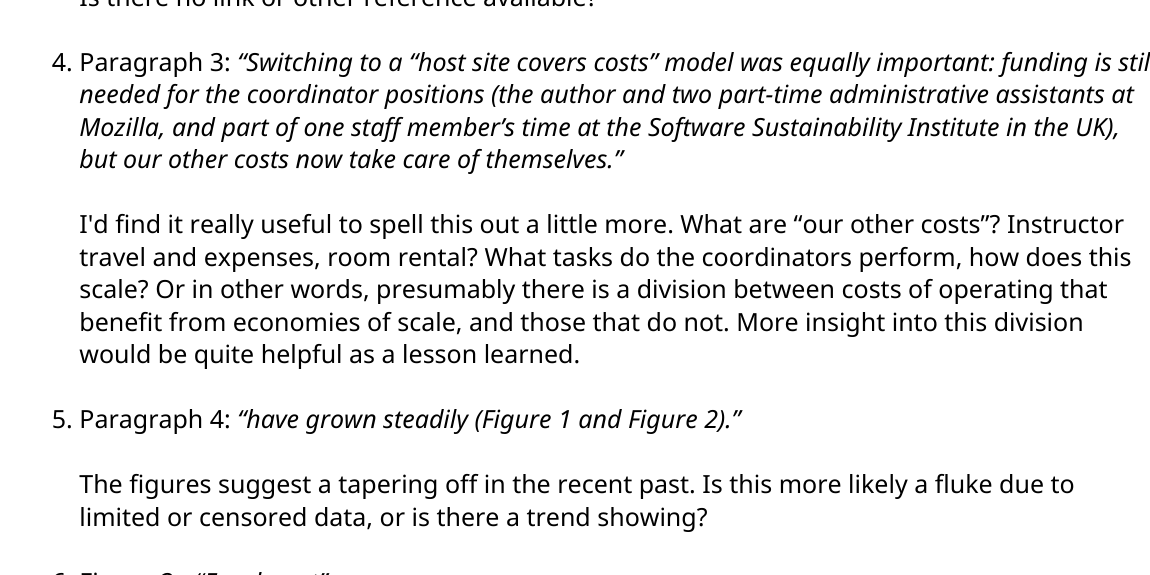
Figure 2 : “Enrolment”